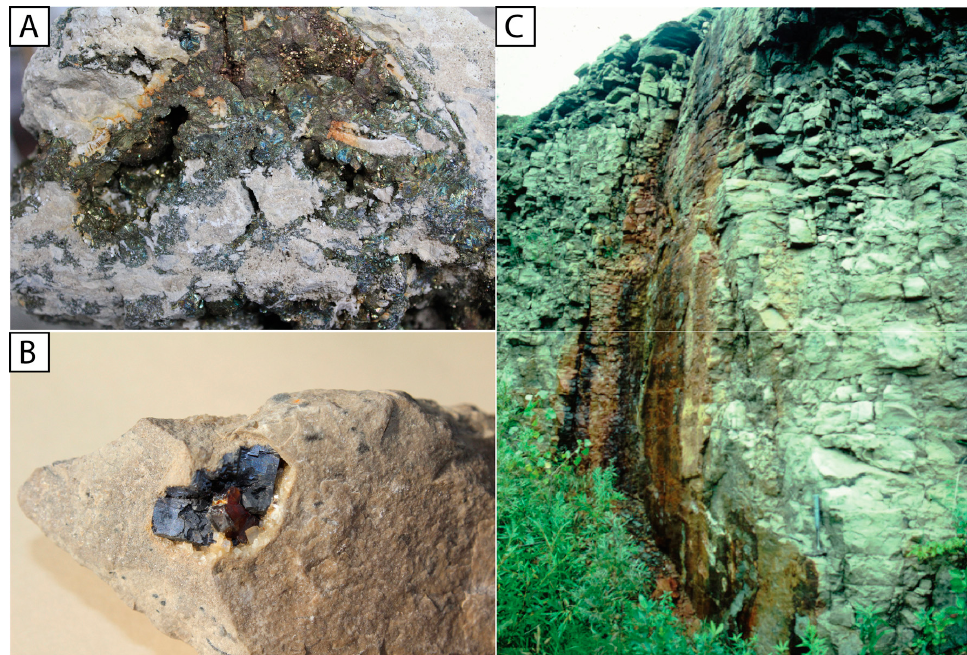
Figure 7. Photographs of selected MVT minerals in Ordovician carbonate strata from northeastern Wisconsin. ( A ) Fe-sulfide cemented dolostone breccia at Locality 48. View is approximately 12 cm across. ( B ) Dolostone hosted galena and sphalerite with hydrothermal dolomite from Locality 82 in Winnebago County. Vug is 2 cm across. ( C ) A small strike-slip fault with several centimeter-wide filling of iron sulfides) at Locality 59 in Winnebago County (note hammer for